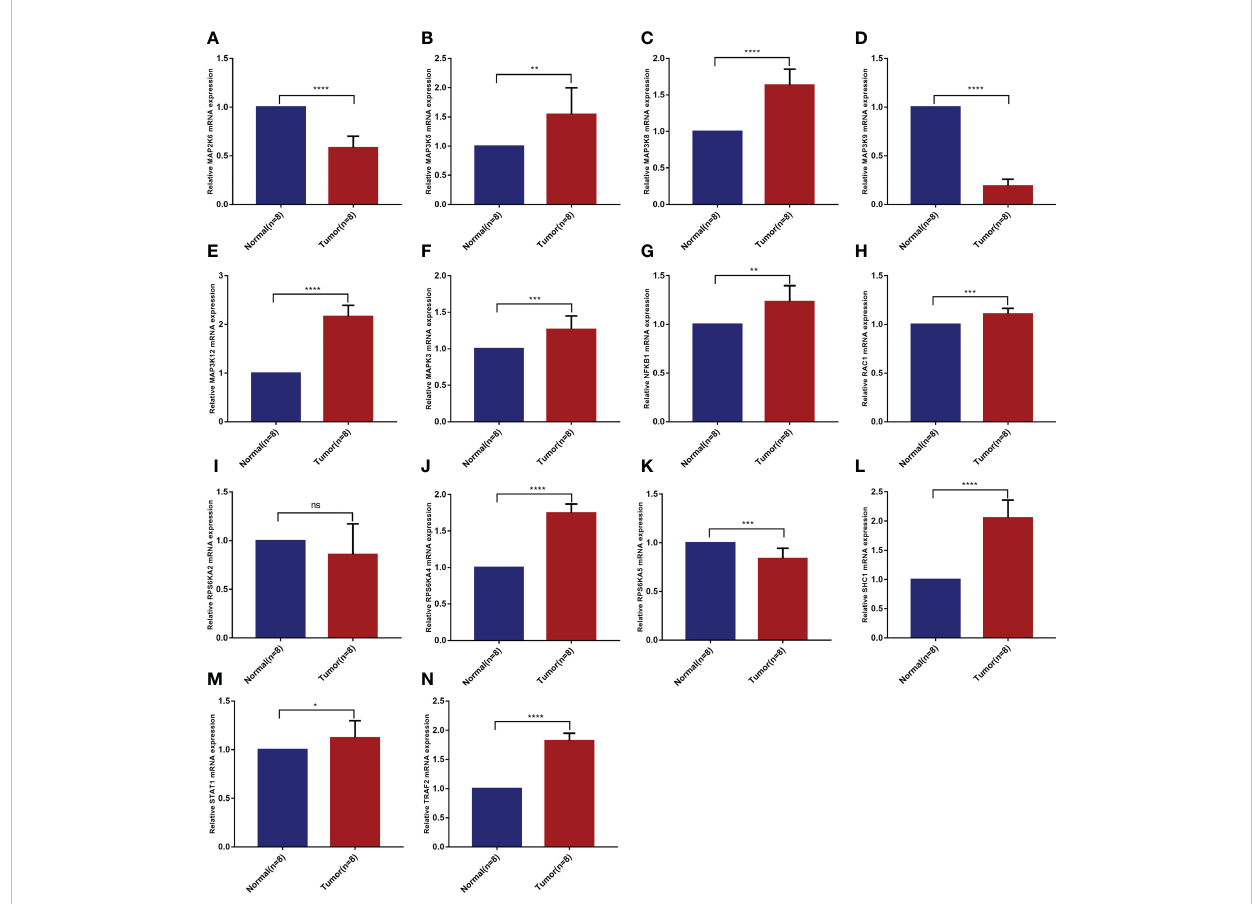
FIGURE 8 Validation of mRNA differential expression of risk model genes between KIRC pathological tissues and normal control tissues based on qRT-PCR. (A) MAP2K6. (B) MAP3K5. (C) MAP3K8. (D) MAP3K9. (E) MAP3K12. (F) MAPK3. (G) NFKB1. (H) RAC1. (I) RPS6KA2. (J) RPS6KA4. (K) RPS6KA5. (L) SHC1. (M) STAT1. (N) TRAF2. *p < 0.05, **p < 0.01, ***p < 0.001, ****p < 0.0001, ns means no signi fi